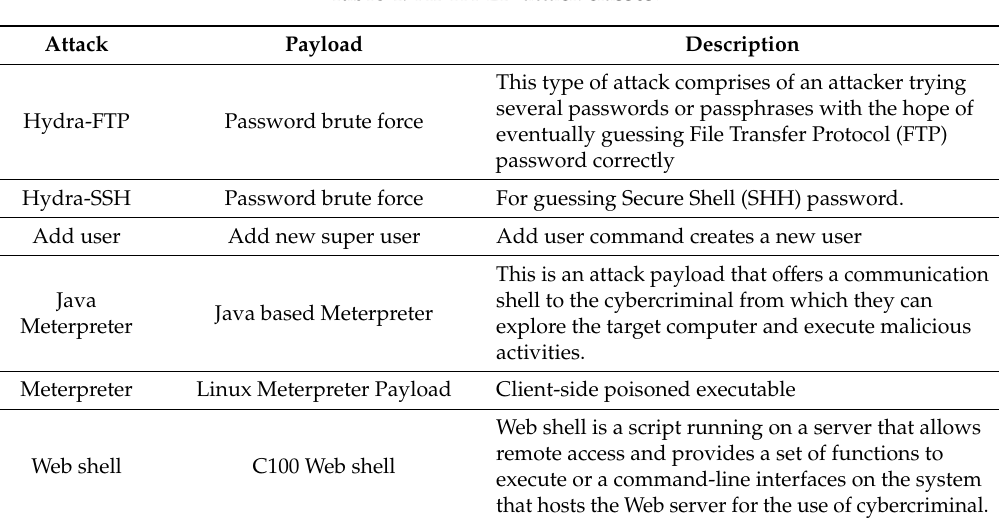
Table 4. ADFA-LD attack